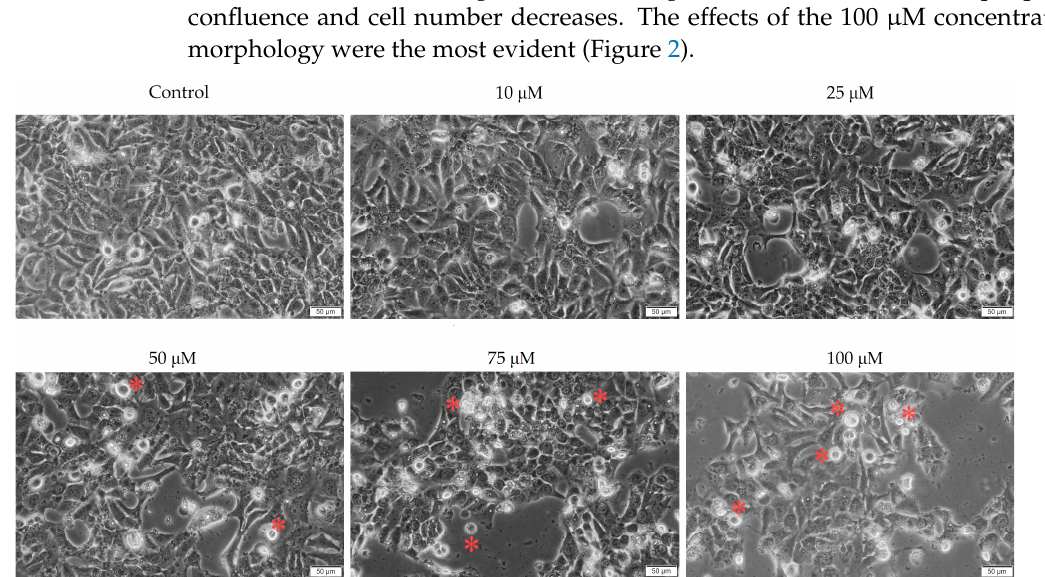
Figure 2. In vitro morphological changes of Detroit-562 cells after 72 h of stimulation with tetracycline (10, 25, 50, 75, and 100 μ M). Asterisks indicate morphological changes. The pictures were taken at a magnification of 20×, and the scale bar indicates 50 μ m.